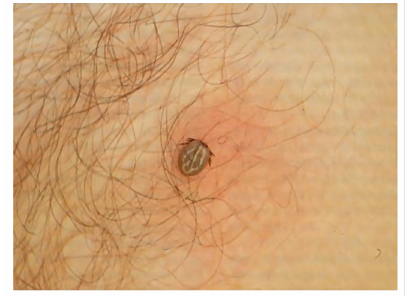
Figure 2. Ixodes ricinus on a man’s leg (photo by G.